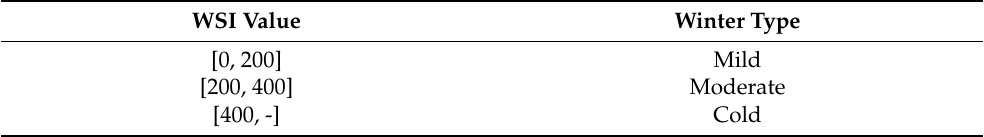
Table 3. Threshold values of WSI used for winter classification (from [1]).